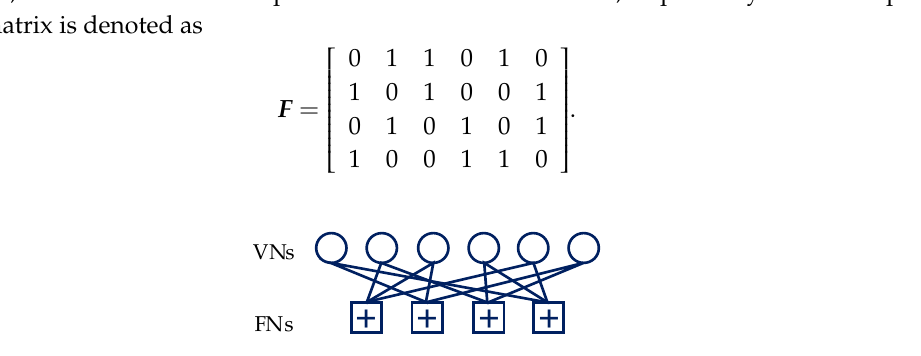
Figure 2. SCMA factor graph with six users and four resources.